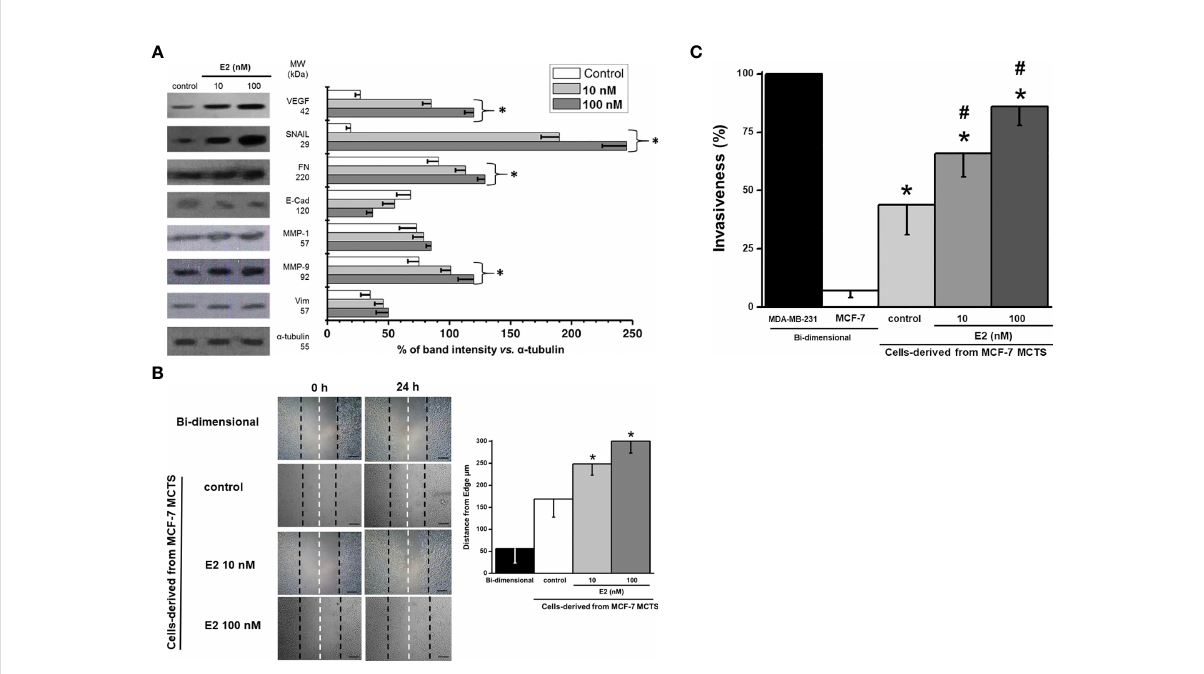
FIGURE 5 Effect of E2 on (A) levels of EMT proteins of MCF-7 MCTS; (B) migration; and (C) invasion of cells derived from MCF-7 MCTS. For cell migration, contrast phase microscope images were taken at the beginning (t=0) and after 24 h E2 exposure, scale bar= 200 µm; right panel represents the distance traveled and calculated from the edge to the center of cell dish. Invasiveness was assessed by using multiwell Boyden chambers as it was indicated in the Material and Methods section. Data shown represent the mean ± S.D. of at least three different preparations. * P <0.05 vs. control (non-treated